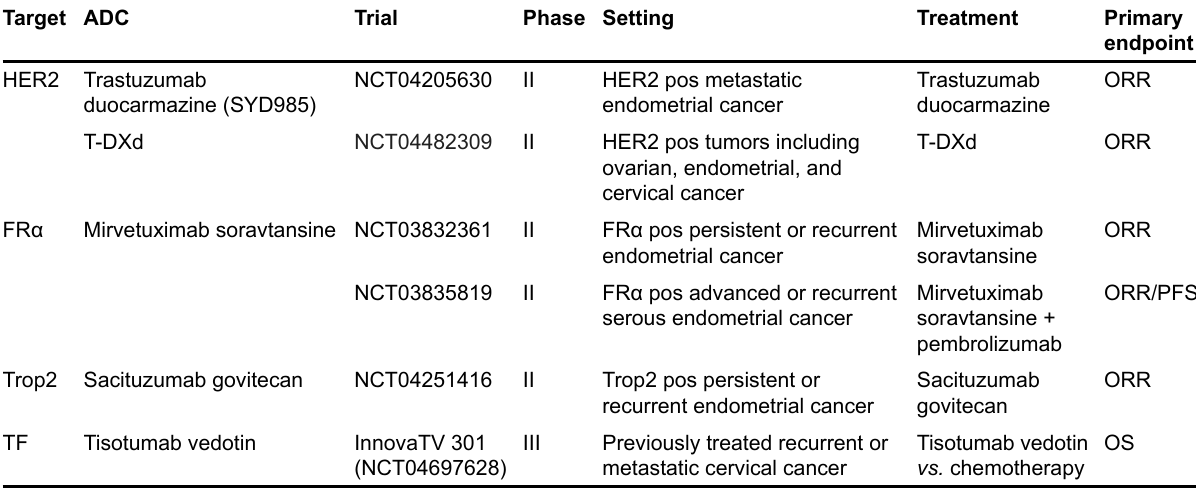
Table 4. Main ongoing clinical trials of ADCs in endometrial and cervical cancer Target